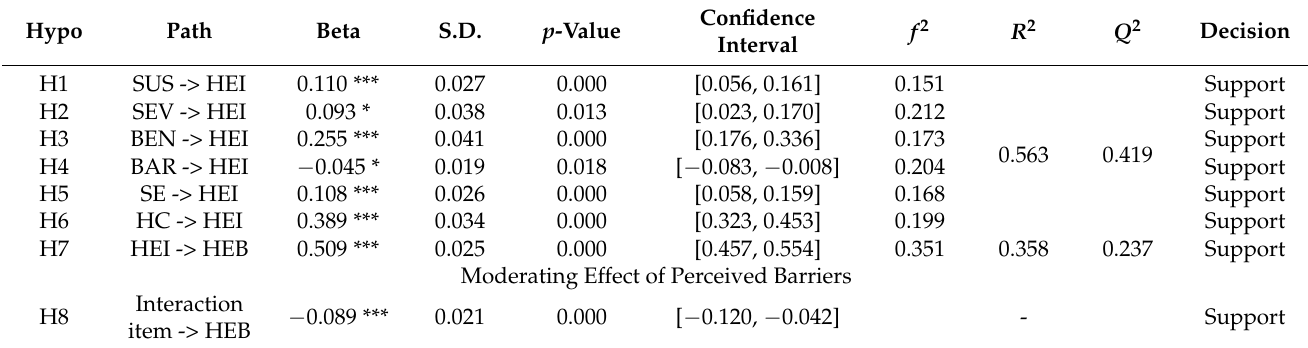
Table 4. Results of hypothesis